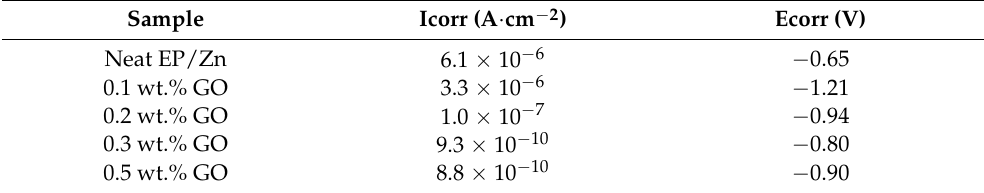
Figure 6. Tafel curve of the coating incorporated with different contents of GO in 3.5 wt.% NaCl solution. Table 1. Icorr and Ecorr of GO/EP/Zn coating with different GO contents in 3.5 wt.% NaCl